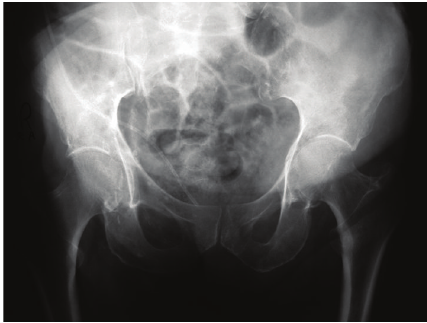
Figure 1: Linear non displaced fracture of the left acetabulum.